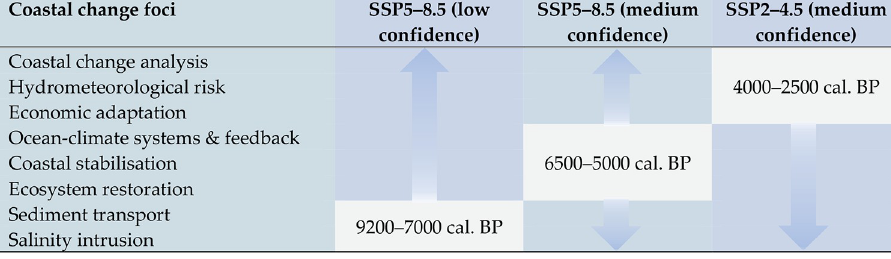
Fig 1. Examples of coastal change foci of attention to which palaeo-data can make significant contributions in the context of modelling human and landscape responses to future sea level rise projections under emissions scenarios SSP5–8.5 and SSP2–4.5. Highlighted time windows represent periods of focus herein; arrows indicate wider applicability of datasets.